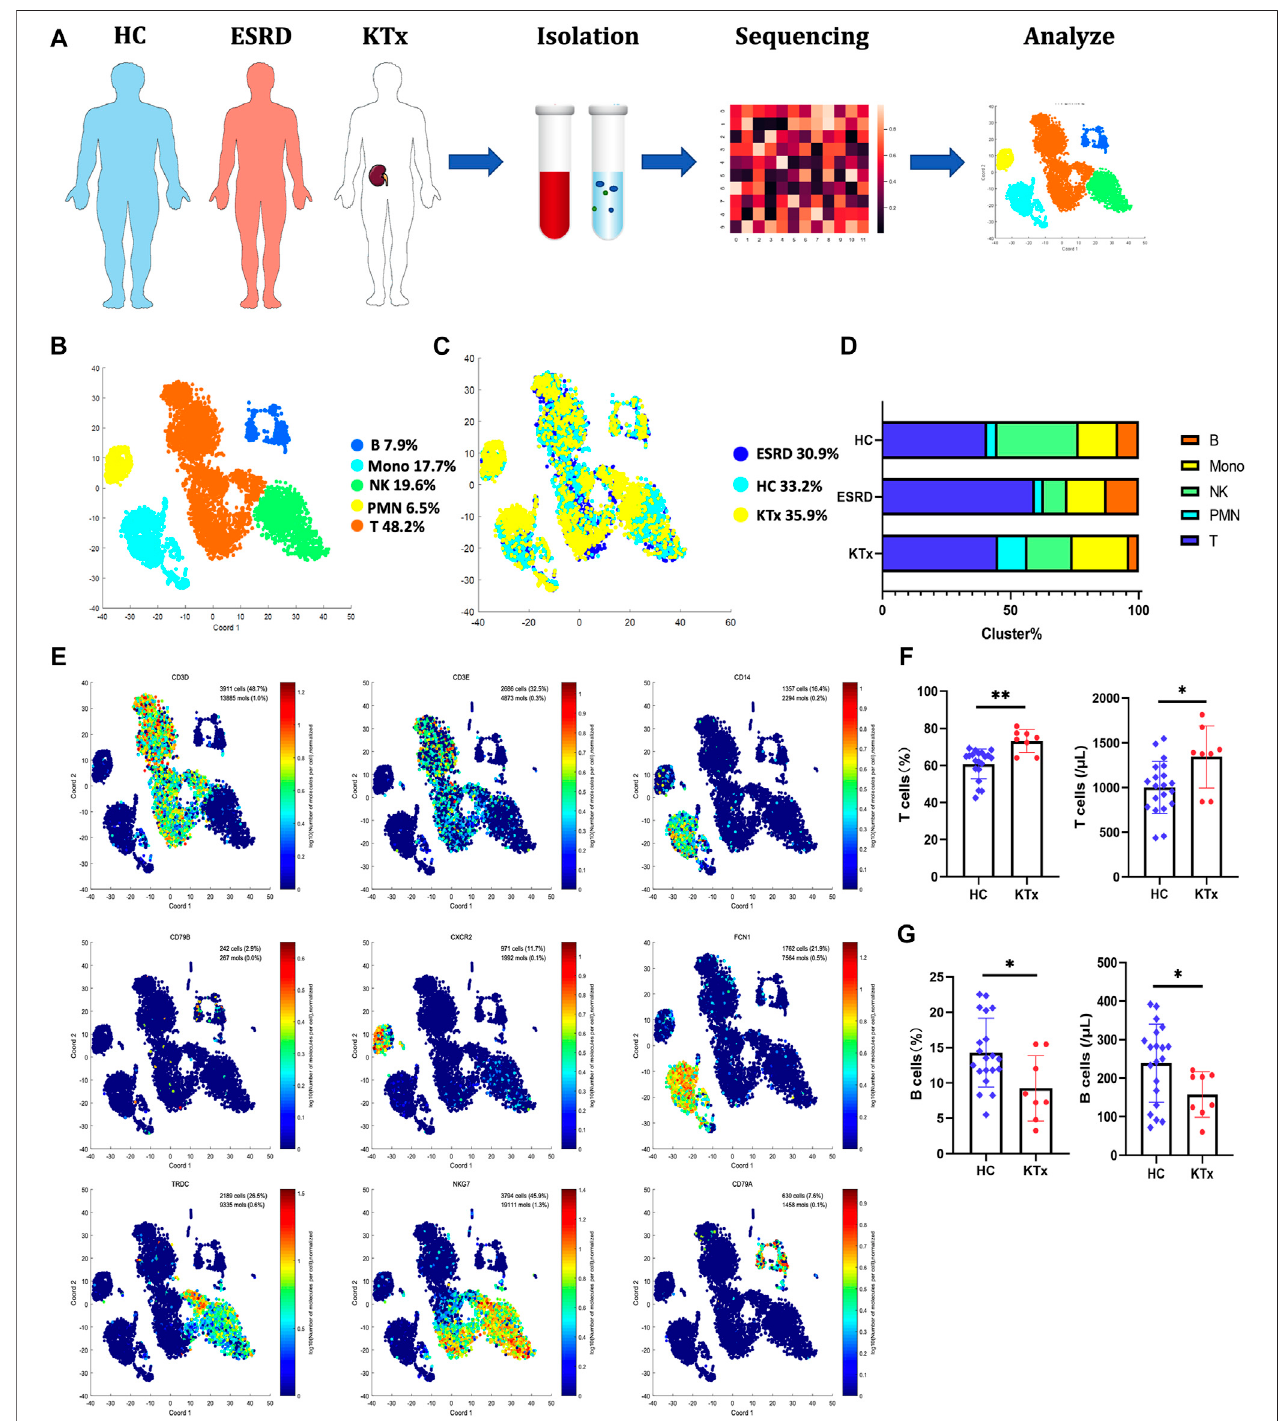
FIGURE 1 | Single-cell transcriptional pro fi ling of PBMCs from HC, ESRD, and KTx. (A) Schematic of experimental work fl ow for de fi ning and comparing PBMCs between three donors. (B,C) tSNE of single-cell pro fi le annotated by a sample type and associated cell type. (D) Different expressions of marker genes in different clustersabove. (E) Fractionofcellsfor5celltypesinHC,ESRD,andKTxindividuals. (F) ProportionandabsolutecountsofCD3 + TcellsinHCandKTxgroups. (G) Ratio and absolute counts of CD19 + B cells in HC and KTx groups. * p < 0.05 ** p < 0.005.